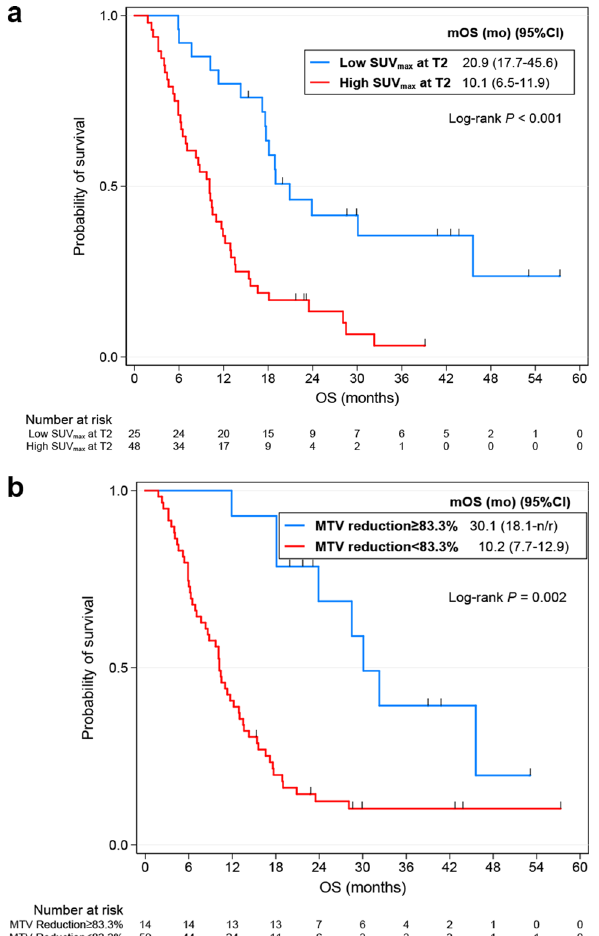
Figure 4. Kaplan–Meier survival curves for overall survival according to the SUV max at TP2 ( a ) and percent change in MTV ( b ). SUV standardized uptake value, MTV metabolic tumor